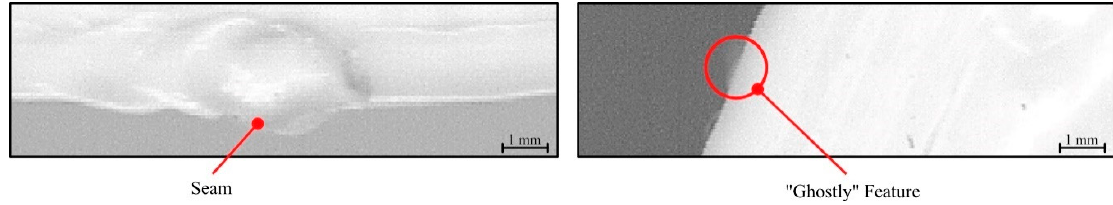
Figure 12. Samples of 𝑆02 original scans showing a seam in the 180° orientation (left) and a “ghostly” feature in the 293° orientation ( right).